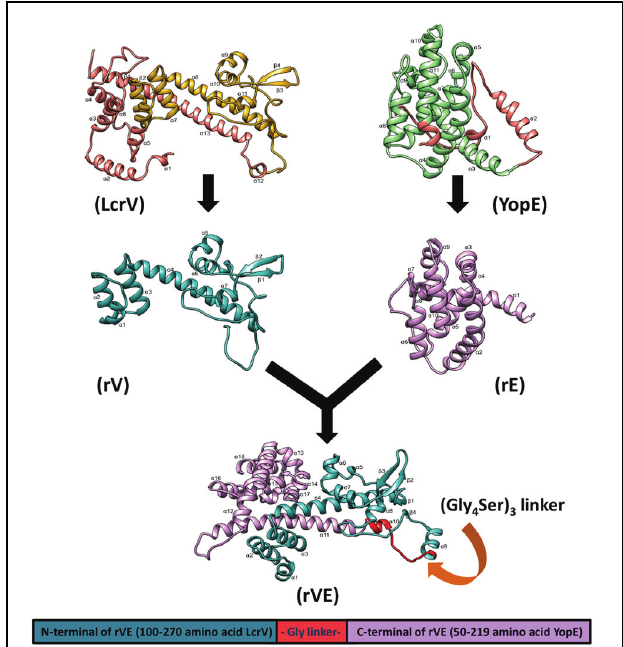
FIGURE 1 | The three dimensional predicted structure of rVE fusion protein as ribbon model, was determined by I-TASSER composite modeling approach. The N-terminal domain (rV) and C- terminal domain (rE) are colored in green and violet, respectively, with omitted regions represented as brown color in both native structures (LcrV and YopE). The recombinant rV and rE components of rVE bivalent fusion protein attached by a flexible glycine linker presented in red